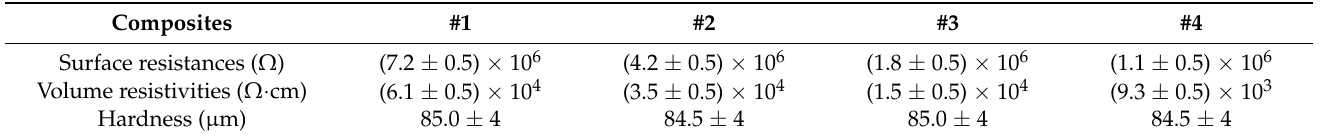
Table 3. Volume resistivities of different WPU SCCs with modified fillers.